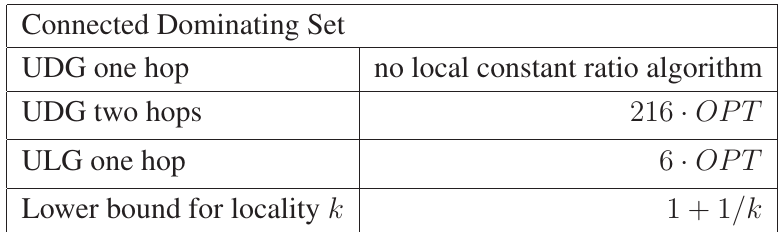
Table 2 . Results for connected dominating set presented in this